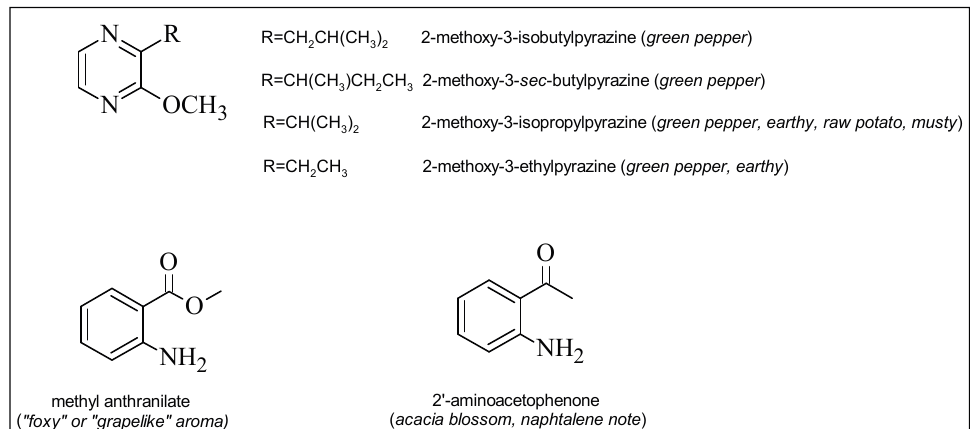
Figure 3. Structures of “foxy-smelling” compounds and alkyl methoxypyrazines in grapes. In brackets, the odor descriptor is reported